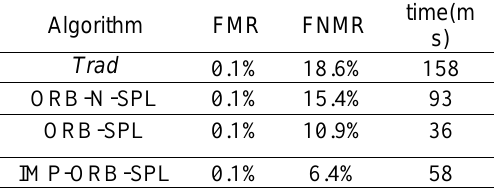
Table 2. Experimental results.